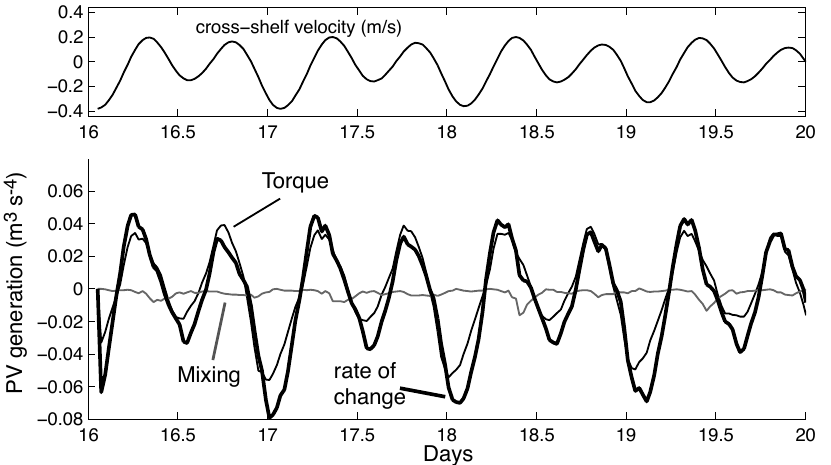
Fig. 10. PV budget over a 20 × 20km box over the cape. The term due to mixing inhomogeneity is very small. The difference between the torque generation and the rate of change of PV in the region is due to